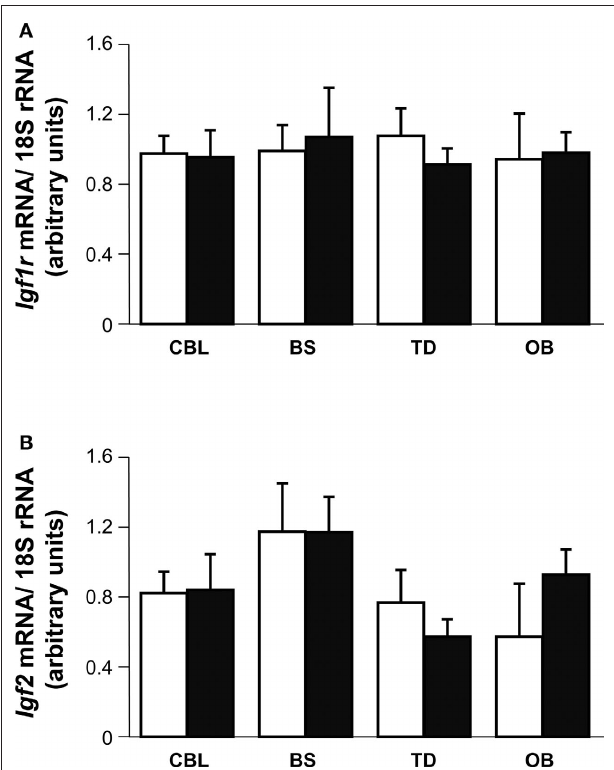
Figure 9 | Brain distribution and expression of Igf2 and Igf1r. Igf1r (A) and Igf2 (B) mRNA levels were measured by quantitative RT-PCR of RNA from the indicated mouse brain regions and normalized to the levels of the 18S ribosomal RNA 3–5 mice per genotype were used. The results represent the mean ± s.d. Brainstem (BS), olfactory bulb (OB), cerebellum (CBL) and the remainder of the telencephalon-diencephalon (TD). Open and closed bars indicate Igf1 + / + and Igf1 − / − mice,